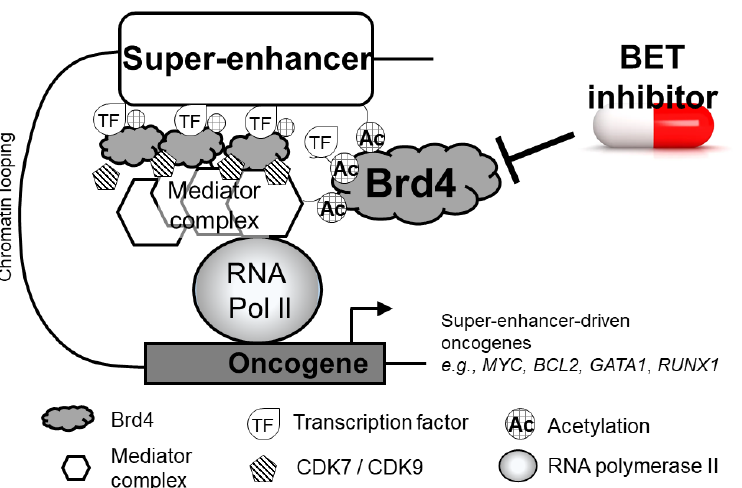
Figure 1. Therapeutic targeting of super-enhancers by BET inhibitors. Brd4 binds to heavily acetylated (Ac) lysines in super-enhancer complexes and transcription factors (TFs), thereby bringing them together and facilitating transcriptional activation and elongation via RNA polymerase II (RNA Pol II) and Mediator. BET inhibitors disrupt the interaction between Brd4 and acetylated lysine residues of super-enhancer complexes to suppress activation of oncogenes.